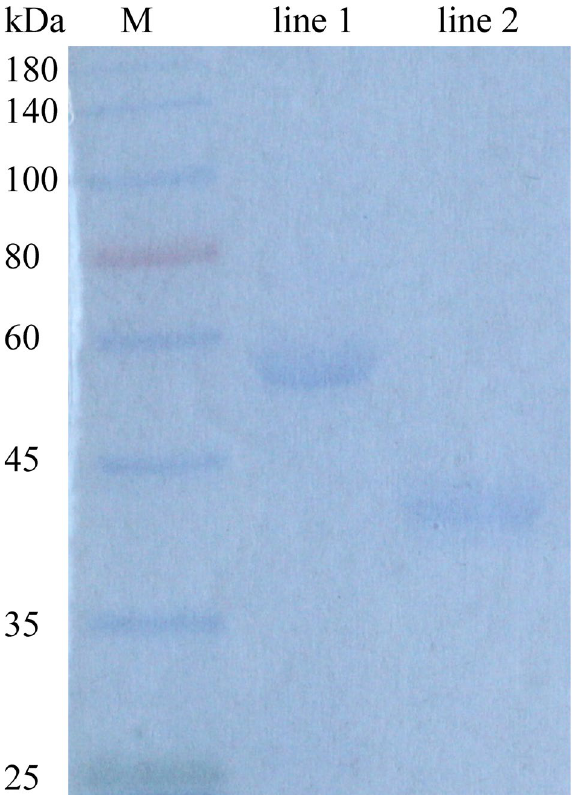
Figure 5. SDS-PAGE gel electrophoresis of PmC1qDC-1 and MBP protein. M molecular mass markers, lane 1 purified PmC1qDC-1 protein, line 2 MBP protein; the molecular mass (kDa) is shown on the left of the gel.